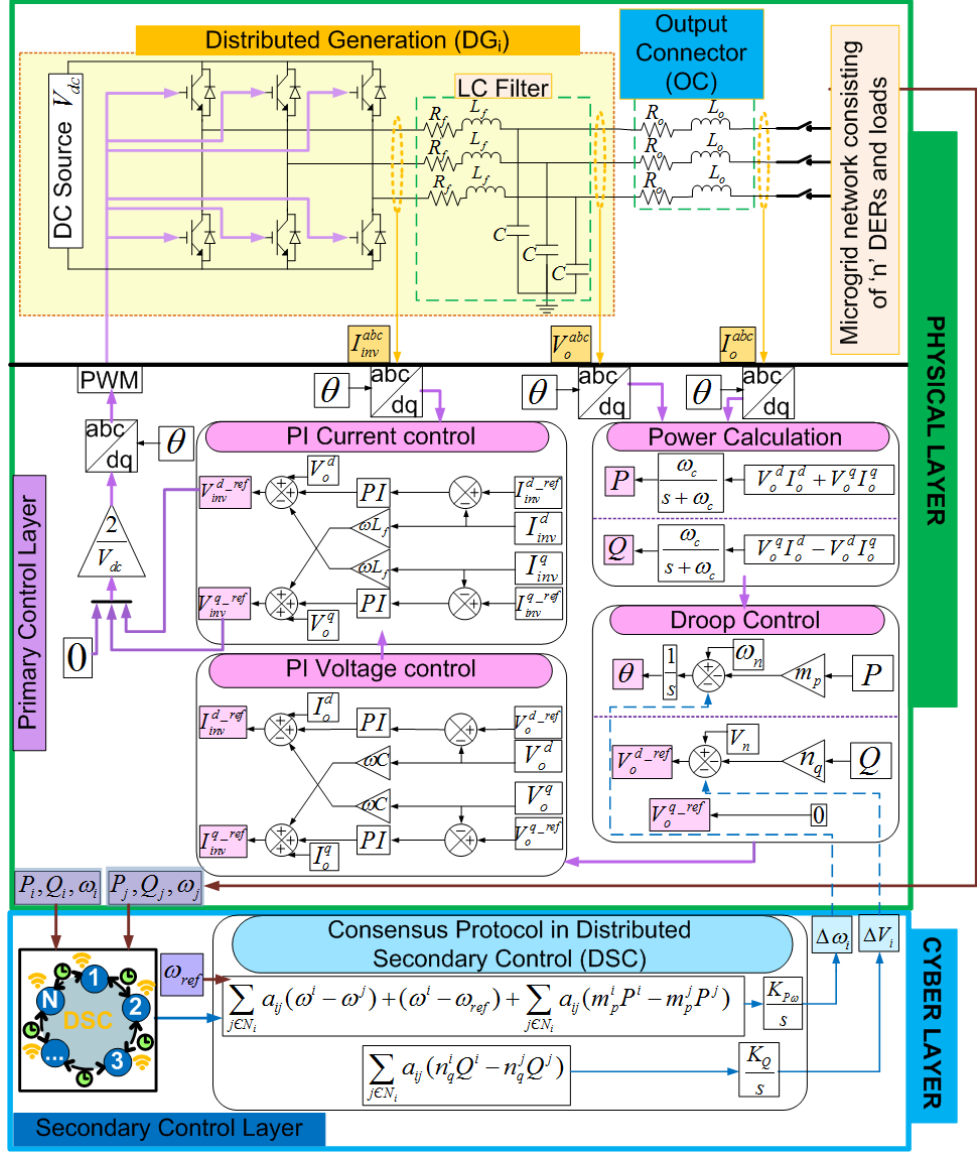
Figure 3. Overall control architecture for an AC microgrid in a cyber-physical